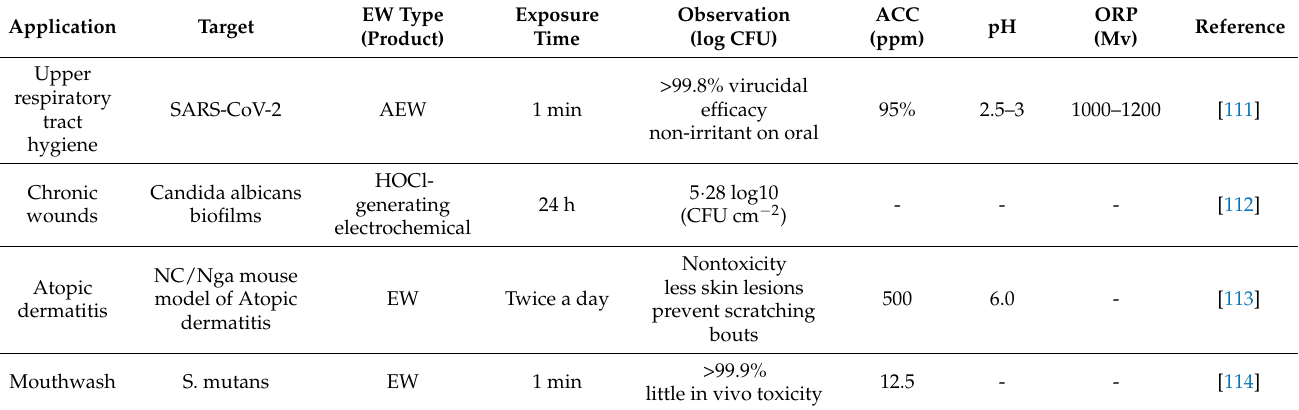
Table 5. Applications of EW against various microorganisms in clinical